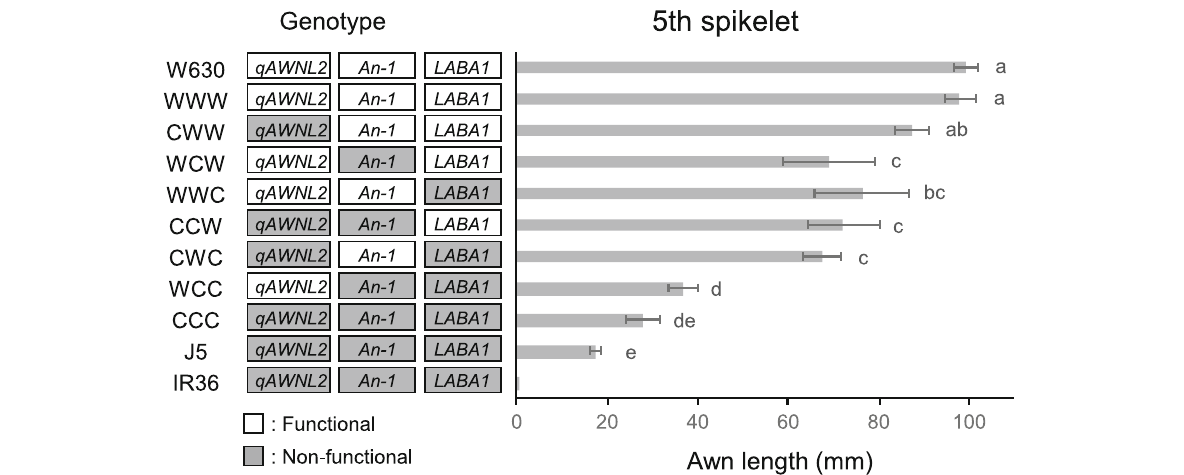
Fig. 3 Awn lengths (means ± SD, n =5) of the 5th spikelets of eight homozygous genotypes in the wild genetic background. These are compared together with the parental accessions of O. rufipogon W630 and the J5 line. Average awn lengths of O. sativa IR36 are shown for reference. Eight genotypes were designated by three-letter combinations of W or C in genotypic order at qAWNL2 , An-1 and LABA1 , where W and C indicate wild and cultivated homozygous alleles, respectively. White and gray boxes with the locus names beside the genotypes indicate functional (wild) and non- functional (cultivated) homozygous alleles, respectively. Means labeled with different letters are significantly different among eight genotypes and two parental lines (Tukey ’ s test, P <0.05)